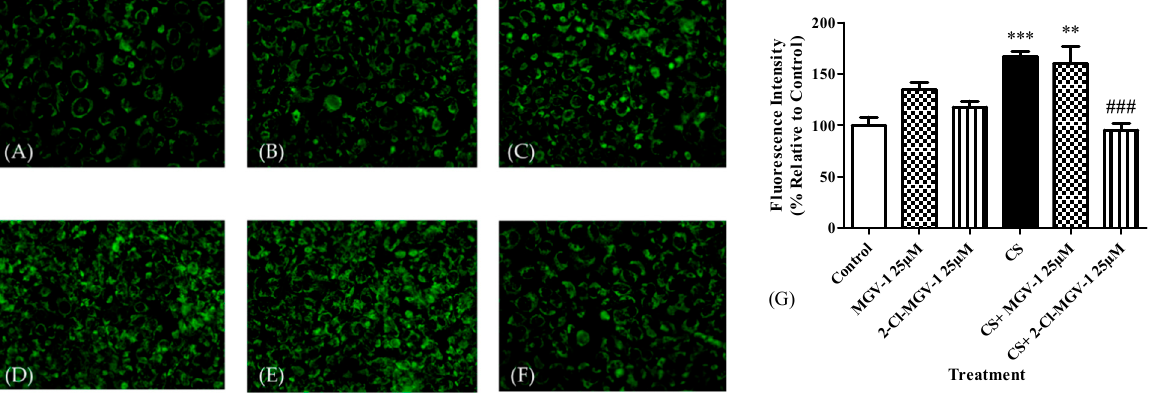
Figure 5. TSPO levels in H1299 lung cancer cells using fluorescence microscopy. The fluorescence intensity using microscopic imaging was measured in ( A ) control group; ( B ) cells pretreated with MGV-1 and exposed to fresh air; ( C ) cells pretreated with 2-Cl-MGV-1 and exposed to fresh air; ( D ) cells exposed to CS without pretreatment; ( E ) cells pretreated with MGV-1 and exposed to CS; ( F ) cells pretreated with 2-Cl-MGV-1 and exposed to CS. ( G ) Representative bar graph. Results are expressed as mean ± SEM ( n = 4 in each group). ** p < 0.01 and *** p < 0.001 vs. control, ### p < 0.05 vs. CS. CS = cigarette smoke.